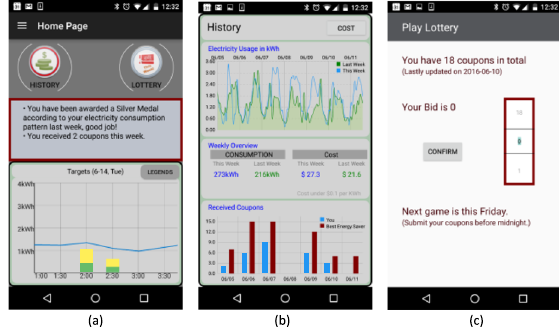
Fig. 2 EnergyCoupon app interface (The EnergyCoupon app is still available on Play Store (Andriod) when this paper is published (2020). Upon agreeing to the terms and conditions, Android mobile users in Texas, US are able to explore some of the functions (such as monitoring real-time energy consumption and submit coupon in lottery) although no EnergyCoupon event and lottery is held right now.). a Main page, coupon targets and tips. b